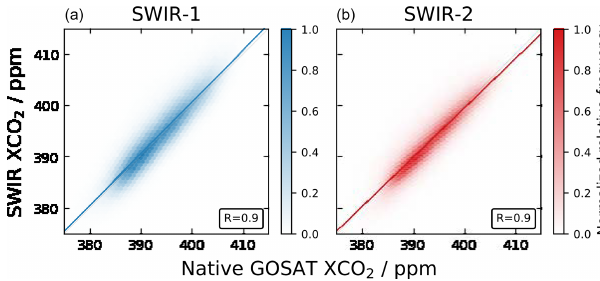
Figure 7. Retrieved SWIR-1 (a) and SWIR-2 (b) XCO 2 plotted ver- sus the corresponding native GOSAT retrievals. The colored lines indicate linear fits to the data, and the grey line marks the 1 : 1 cor- relation. Scatter amounts to 2.85 and to 2.69ppm in SWIR-1 and SWIR-2, respectively. Correlation coefficients are displayed in the lower right corners of the panels. Color shading encodes relative occurrence of data